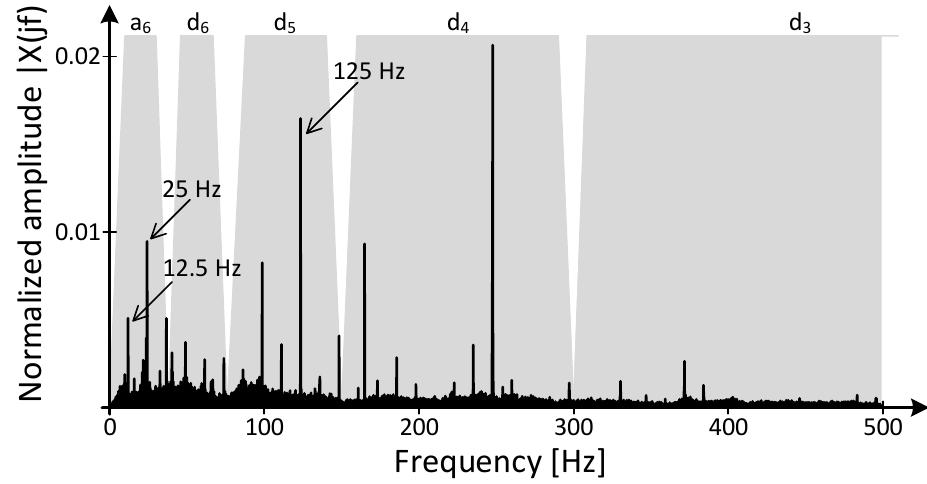
Figure 13. Frequency characteristics of the recorded signal. Gray areas represent the frequency bandwidth of the corresponding DWT coefficients: 𝑎 6 , 𝑑 6 , 𝑑 5 , 𝑑 4 and lower frequency parts of 𝑑 3 .